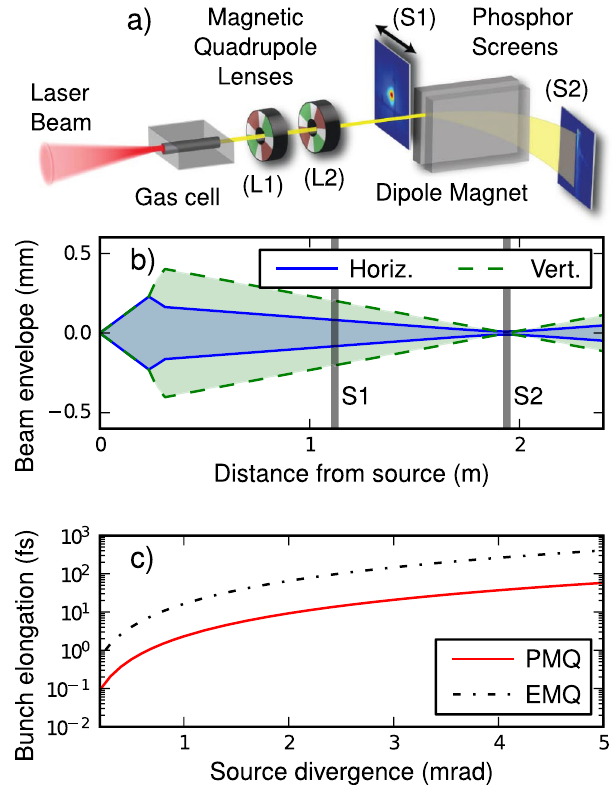
FIG. 1. Experimental setup and electron beam evolution: (a) A laser pulse is focused into a 15 mm long hydrogen-filled gas cell and accelerates electrons to (cid:1) 200 MeV . The electrons pass through a pair of magnetic quadrupole lenses (cid:1) 20 cm behind the gas cell which can focus, collimate, and steer the electron beam. The first lens (L1) is 17 mm long and the second lens (L2) 15 mm. Both lenses have a measured field gradient of (cid:1) 500 T = m . The spatial characteristics of the beam are observed on a removable scintillating screen (S1) 1.12 m behind the exit of the gas cell. A dipole magnet with field strength (cid:1) 0 : 45 T disperses the beam which then allows the observation of the energy spectrum by a second scintillating screen (S2) 1.94 m behind the gas cell. (b) Envelope of a 200 MeV electron beam with source size 1 (cid:1) m and source divergence 1 mrad focused at S2 with lenses as described in (a). (c) Bunch elongation against the rms source beam divergence for focusing at S2 with a PMQ and an EMQ doublet, the bunch has zero initial